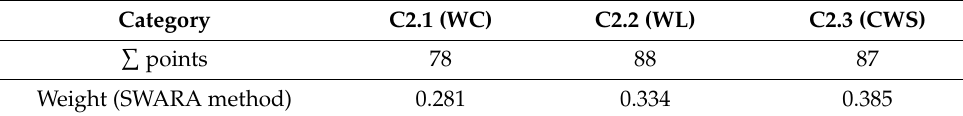
Table 19. Determination of weights of water services indicators.